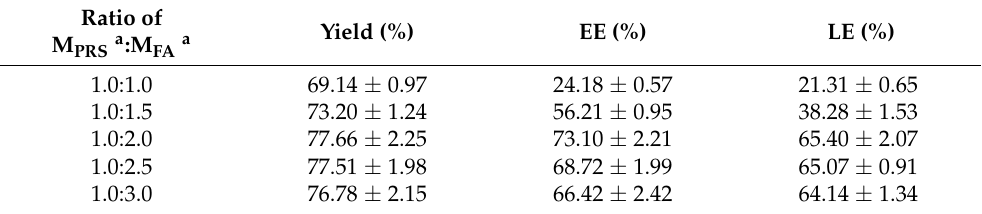
Table 1. Key evaluating parameters of encapsulating FA with various ratios between PRS and FA. Ratio